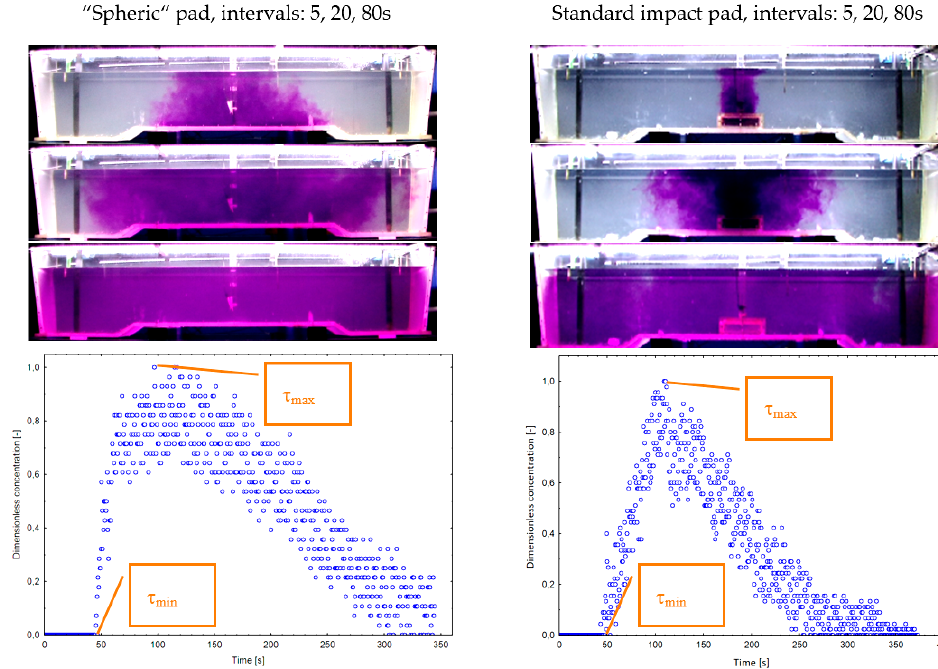
Figure 8. Visual and graphical comparison of flow for “Spheric” impact pad and for standard impact pad at simulated casting speed 1.6 m · min − 1 —physical simulation.